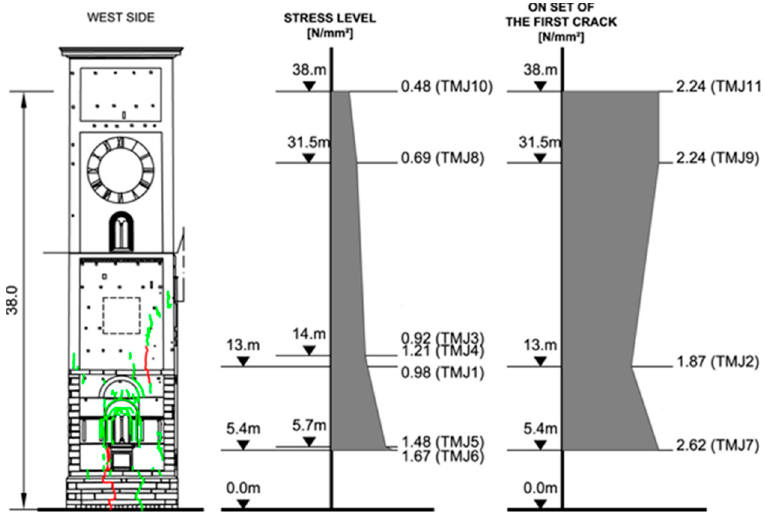
Figure 13. Bell Tower of the Monza Cathedral. Comparison between the distribution of the local state of stress measured by single flat-jack test and the stress on set of the first crack by double flat-jack test [16]. Infrastructures 2020 , 5 , x FOR PEER REVIEW